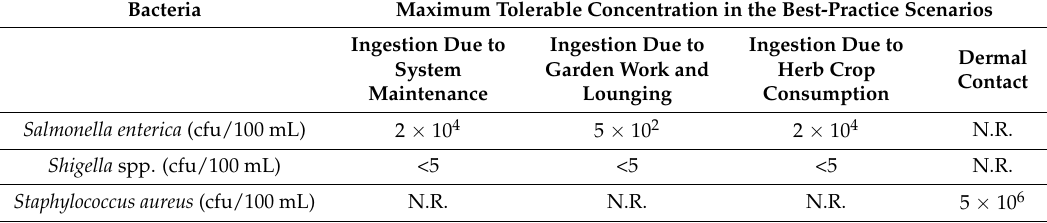
Table 4. Best-practice scenarios for maximum tolerable concentration of the tested pathogens above which the DALY limits are